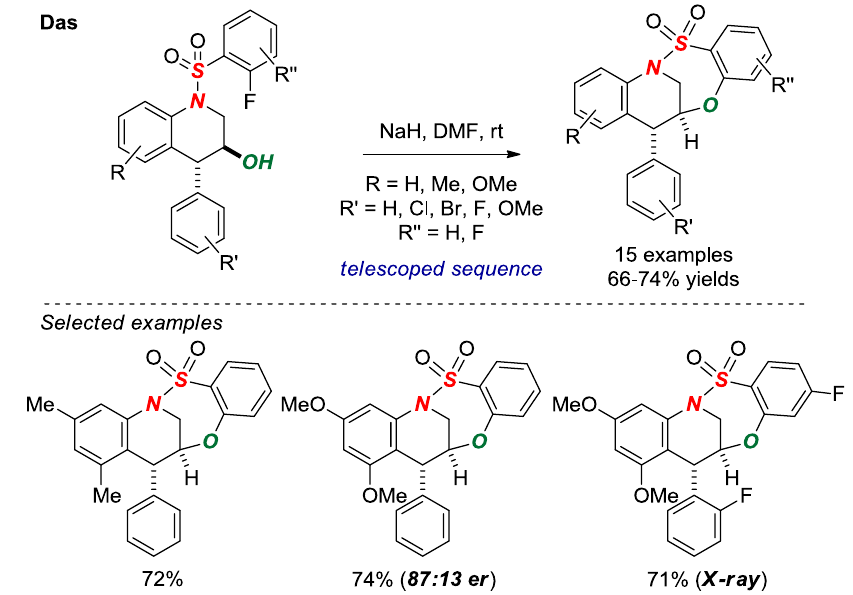
Figure 17. Synthesis of Bridged Benzothiaoxazepine-1,1-dioxides via S N Ar Cyclization.